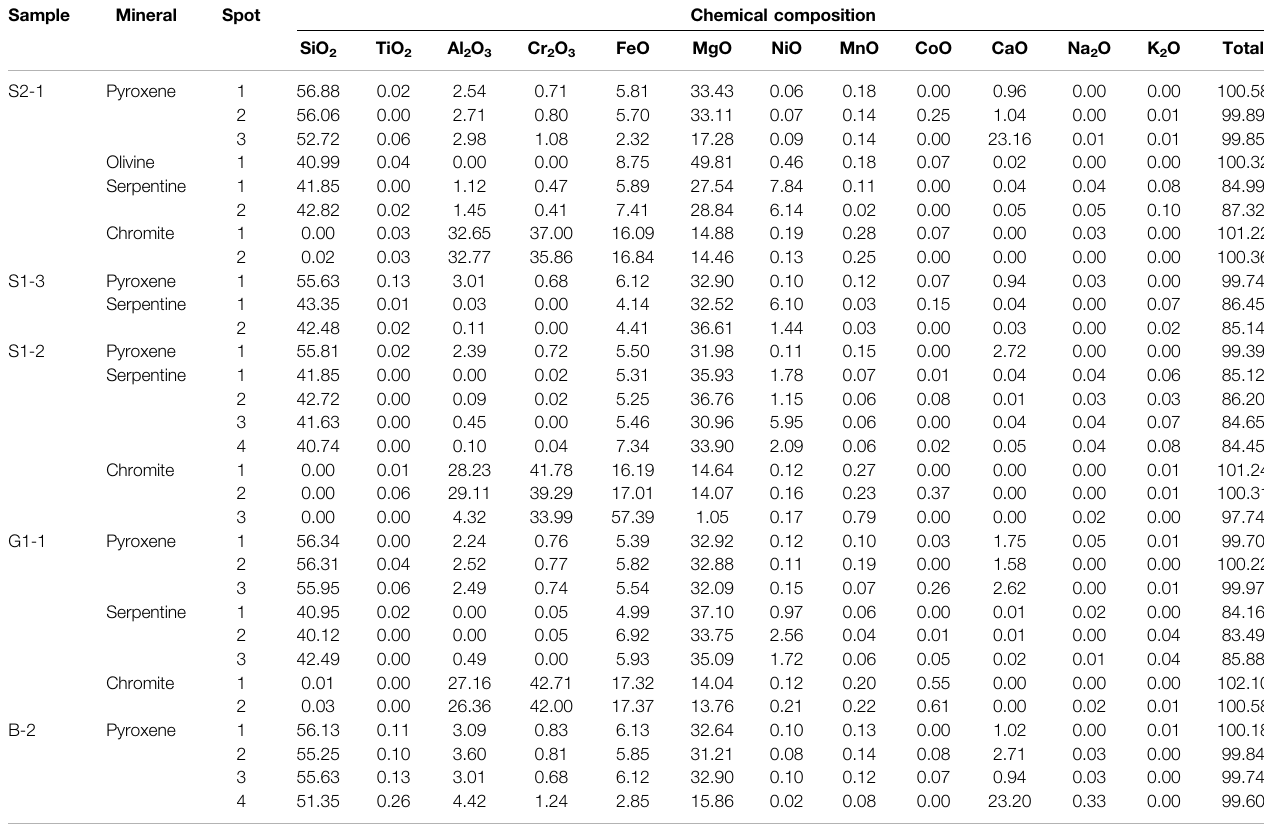
TABLE 3 | EPMA data from minerals in the bedrock and saprolite (in wt%). Sample Mineral Spot Chemical composition